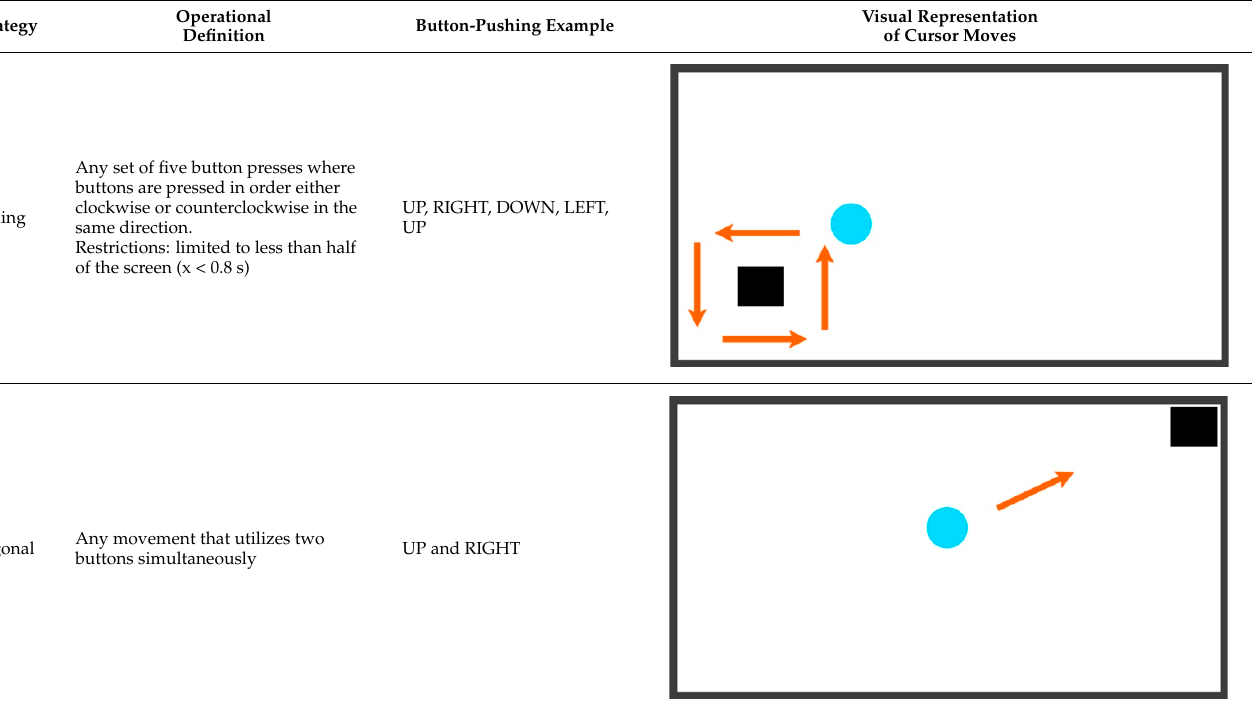
Table 1. Focal strategies, operational definitions, and visual examples.